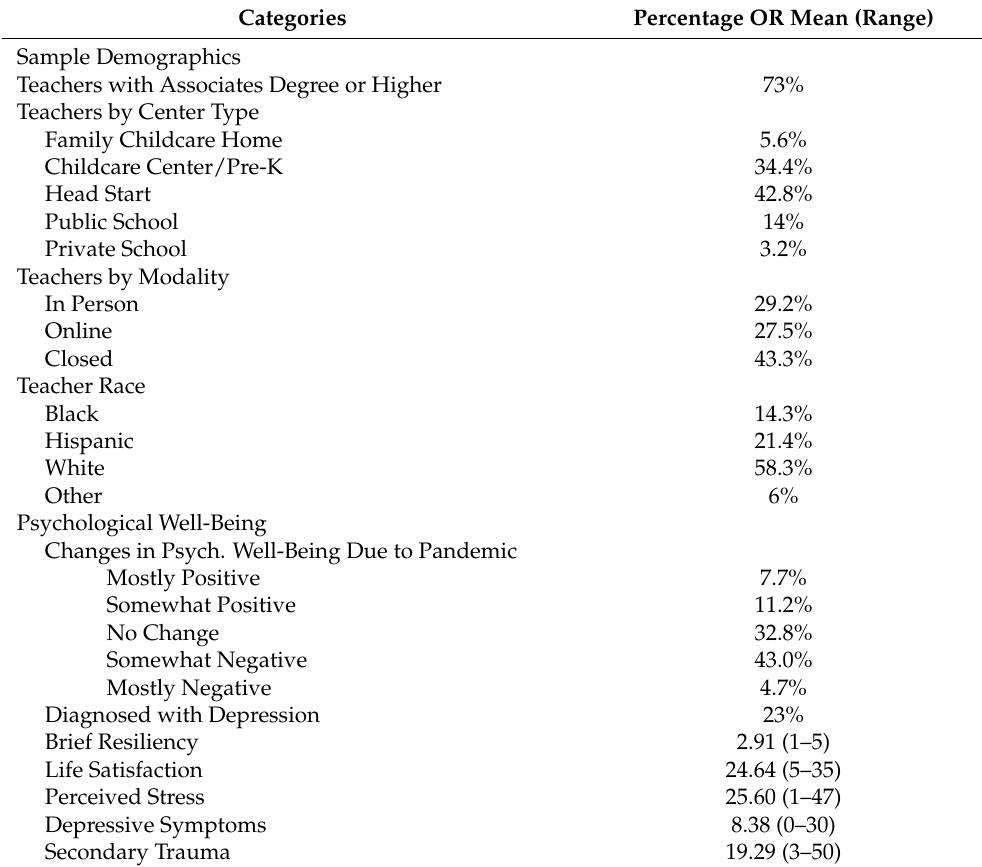
Table 2. Psychological and physical well-being of 1434 ECE teachers during pandemic.